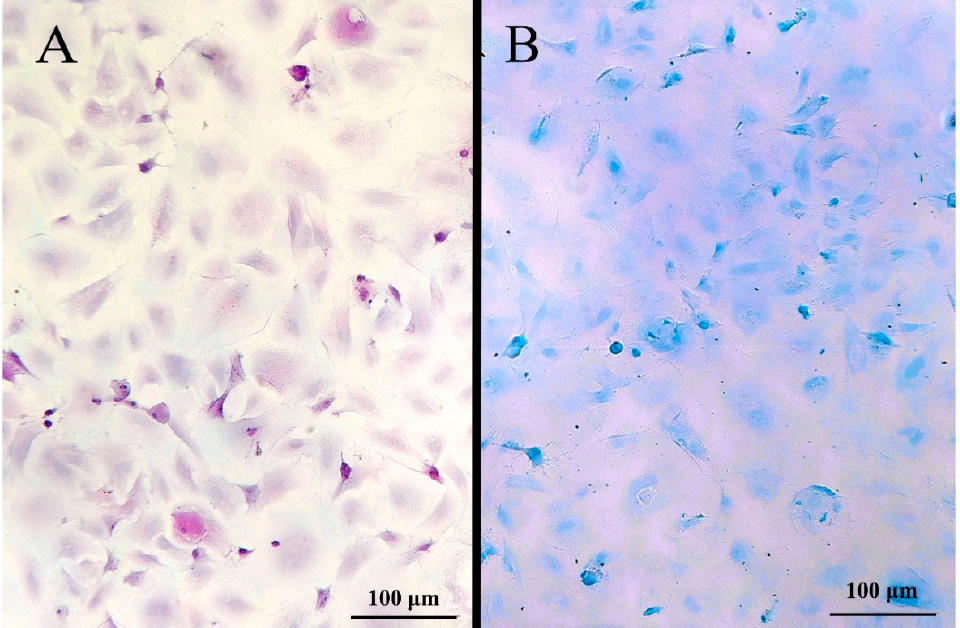
Figure 5. LG-1 cells stained with PAS ( A ) and Alcian blue ( B ) to clarify the presence of mucus cells (bright pink or blue, respectively). Microscope: Leica